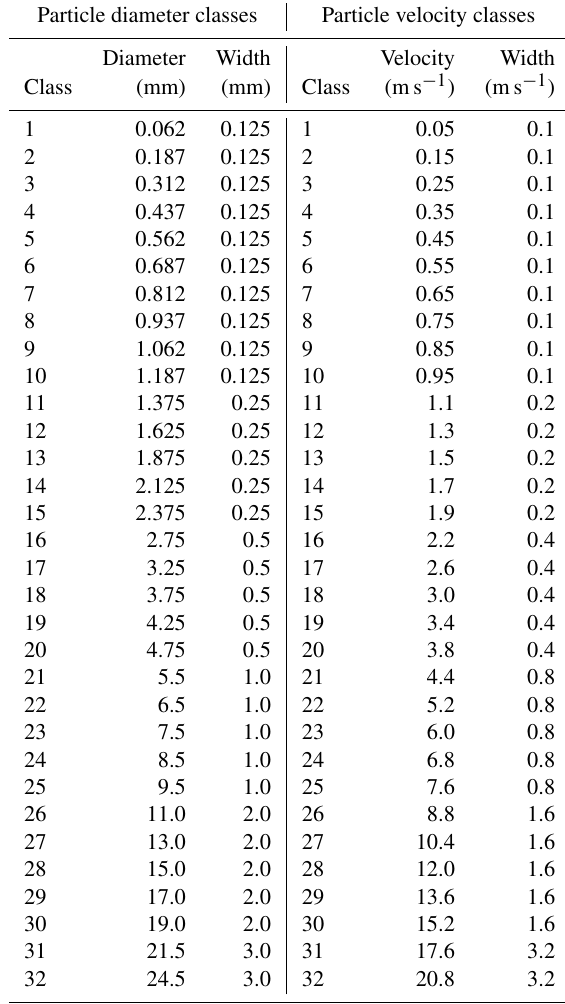
Table 1. Definition of the classes of particle size and velocity for the Parsivel 2